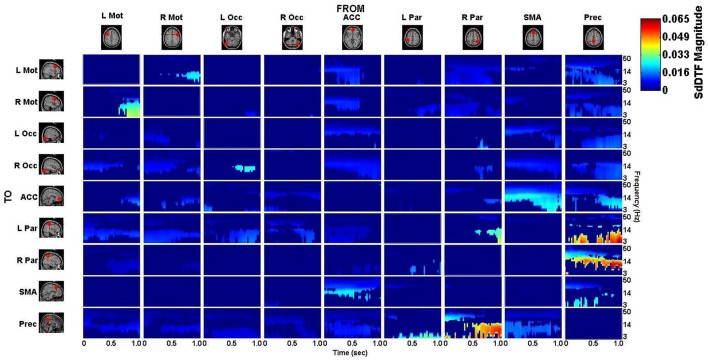
p-value thresholded spectro-temporal asymmetric cortical connectivity matrix for the reach/saccade condition. Network sources are tabulated at the columns and sinks at the rows. The dynamic causal relationship between each source and sink is expressed by the corresponding SdDTF in the pertinent location in the connectivity matrix. Non-zero connectivity is displayed only at spectro-temporal points with p < 0.05, thus only displaying statistically significant connectivity in the cortical network for the Reach/Saccade condition. Note the frequency axis is plotted on a logarithmic scale to more clearly show lower frequency band connectivity, where the majority of causal flow occurs in this network.